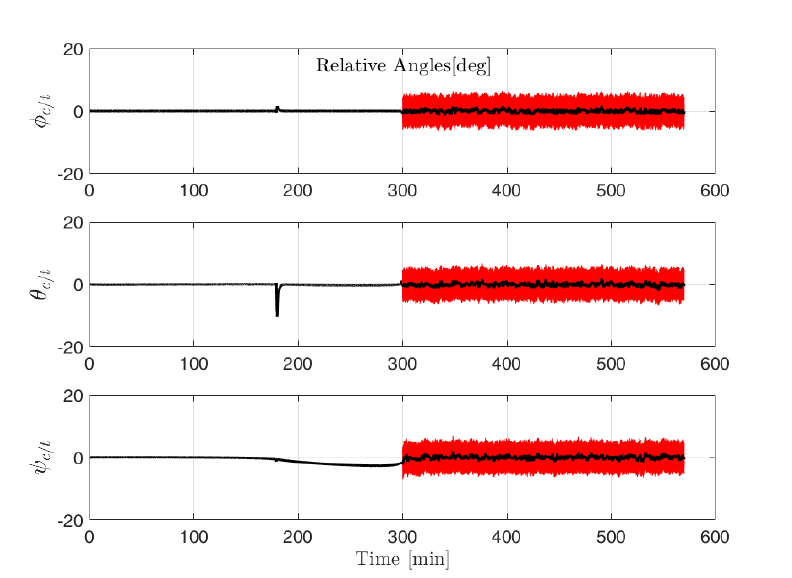
Figure 19. Relative angles with their measurements.